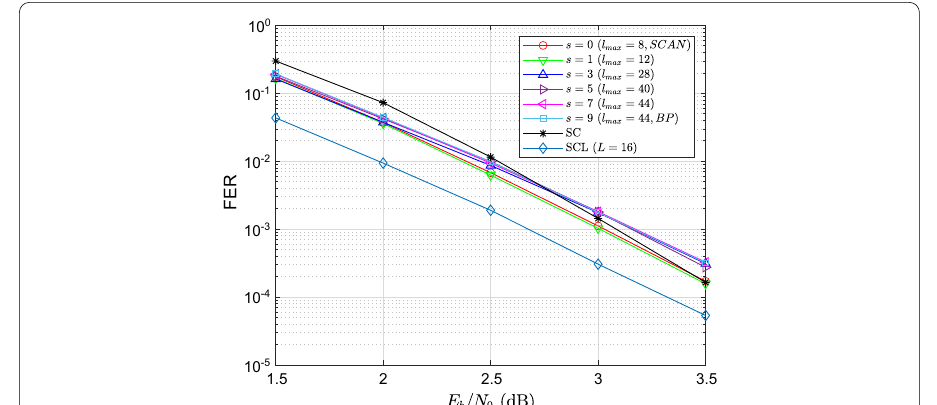
1024 and R 1 / 2 . The = =